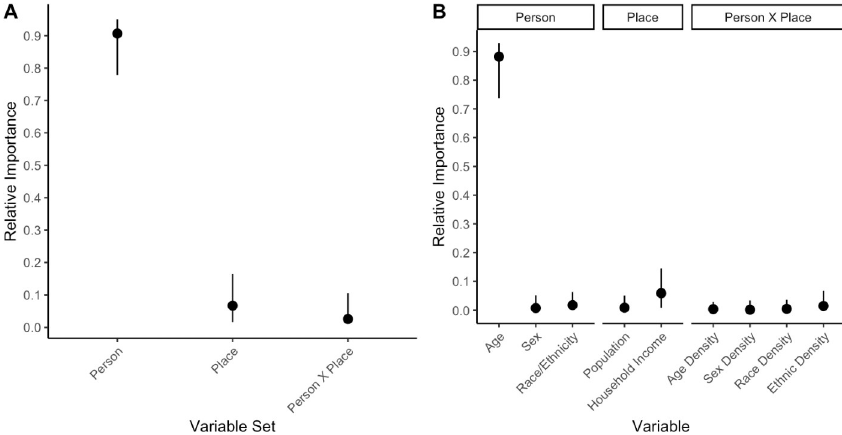
Fig 1. The relative importance of the variable sets (A) and the individual variables within each variable set (B). Errors bars represent bootstrapped 95% CIs.